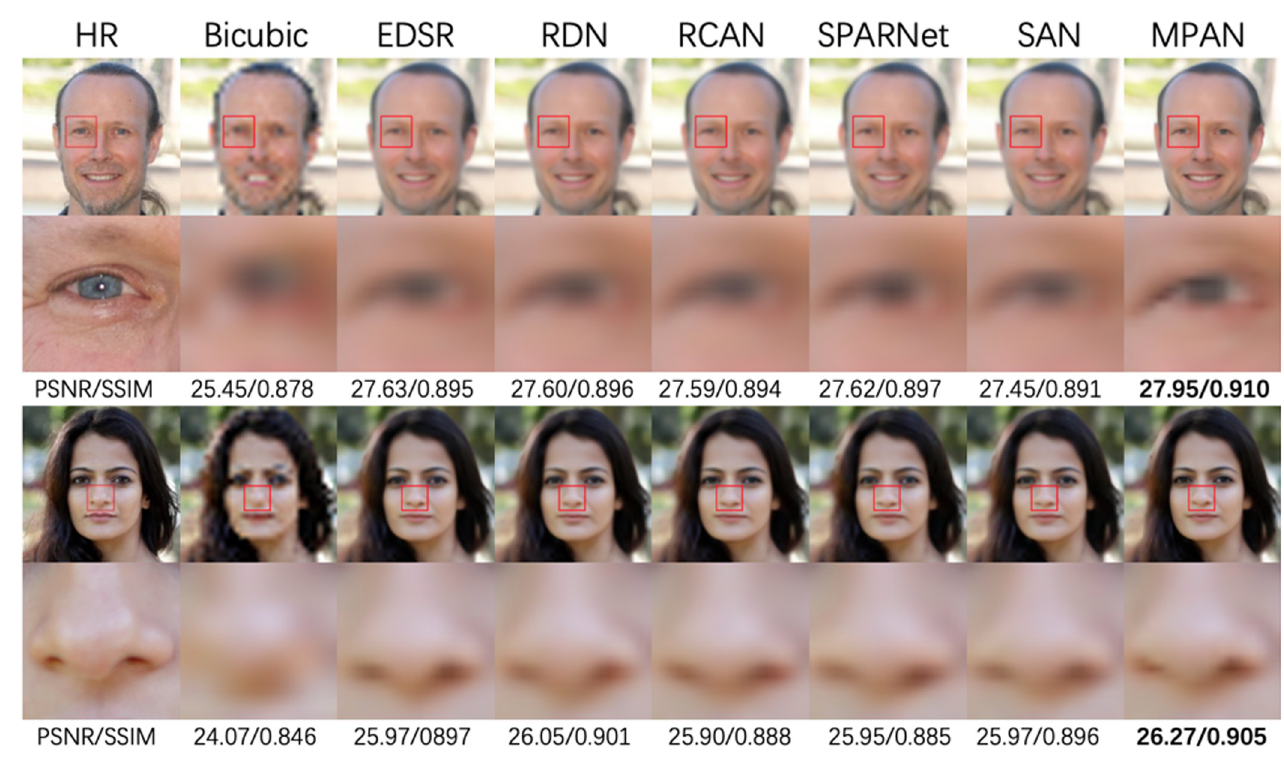
Fig 6. Visual comparison for 4X SR on our face dataset. The best results are bold.